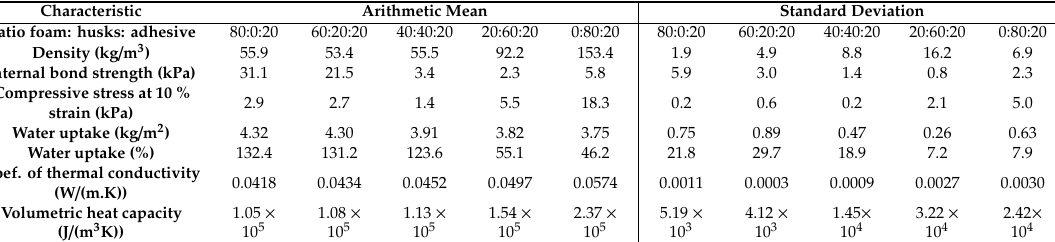
Figure 1. Cross section of the panels. Ratio foam: husks: adhesive: ( a ) 80:0:20; ( b ) 60:20:20; ( c ) 40:40:20; Table 3. Parameters of insulation boards.